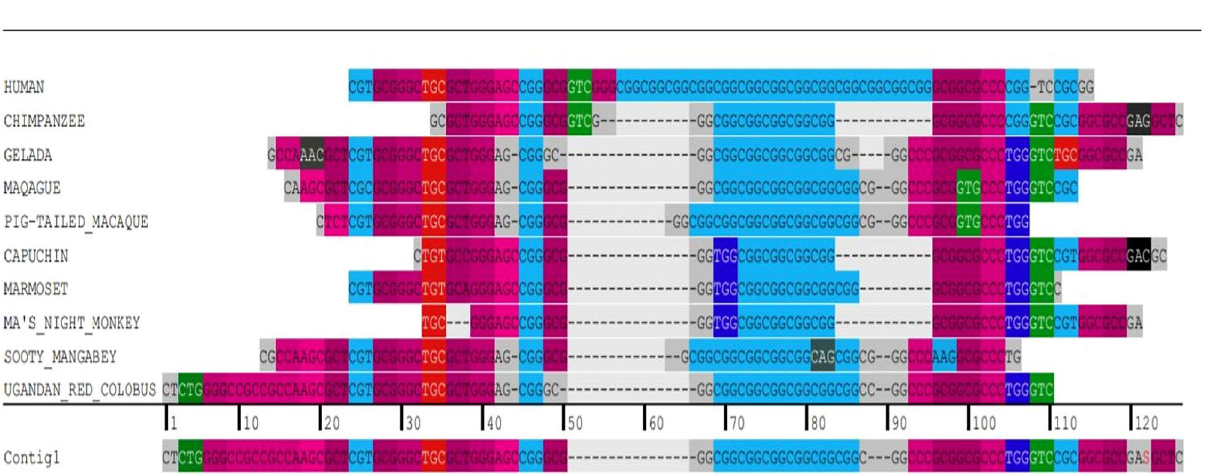
Figure 5. Sequence alignment of the RASGEF1C (GGC)-repeat across primate species, using CodonCode. The (GGC)-repeat was at maximum length in